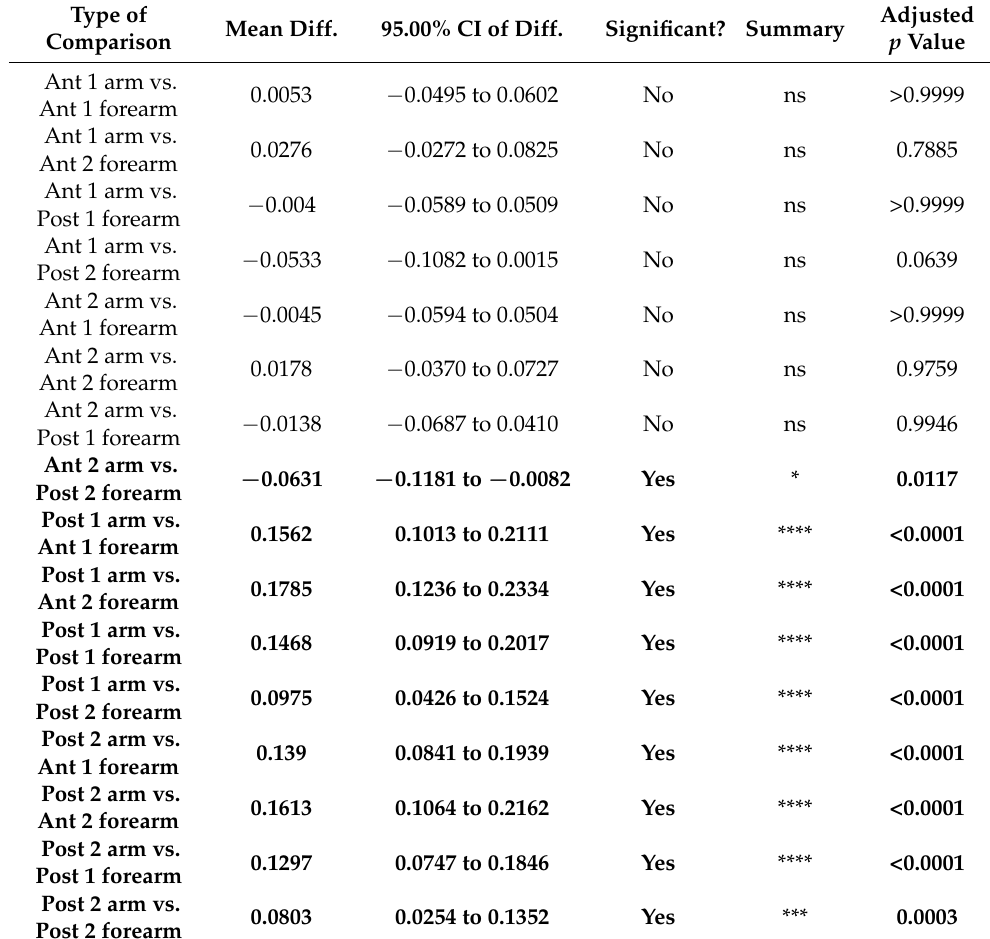
Table 6. Ultrasound measurements within different regions/levels of the superficial fascia of arm and of forearm. Statistically significant results are showed in bold. *: p < 0.05; ***: p < 0.001; ****: p < 0.0001. ns: not statistically significant.